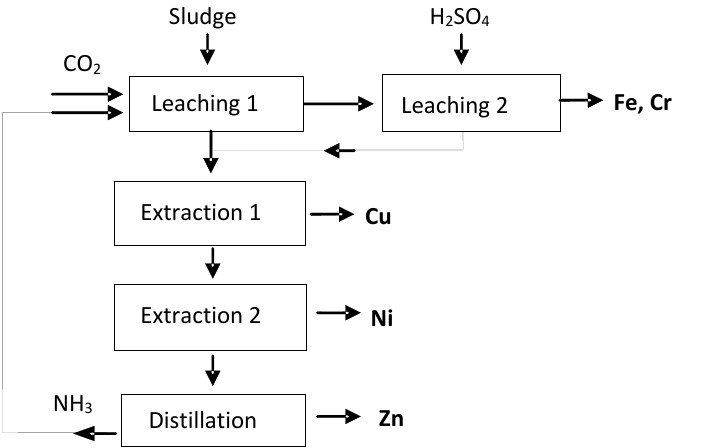
Figure 1. Block diagram of “MAR-Process” technology for galvanic sludge processing [19].